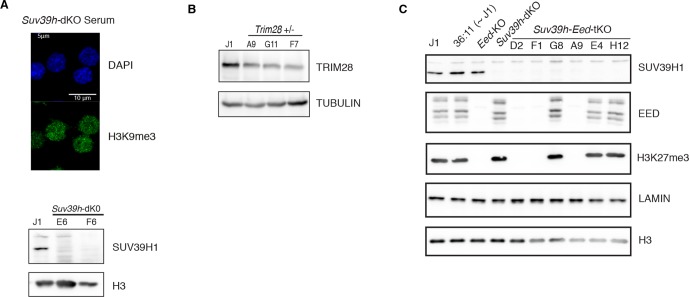
Caracterization of genetic mutants.(A) Characterization of Suv39h-dKO ES cells: loss of H3K9me3 at pericentric heterochromatin assessed by immunofluorescence (upper panel, compare with Figure 4—figure supplement 1A at D0 for WT) and lack of SUV39H1 protein assessed by western blot (lower panel). (B) Characterization of CRISPR/Cas9- generated Trim28+/- ES cells: western blot showing the level of reduction of TRIM28 protein in three independent clones. Clone F7 was used for subsequent experiments. (C) Characterization of CRISPR/Cas9- generated Suv39h-Eed-tKO ES cells: western blot showing lack of SUV39H1, EED and H3K27me3 in independent clones. Clones D2, F1 and A9 were used as biological replicates in subsequent experiments.